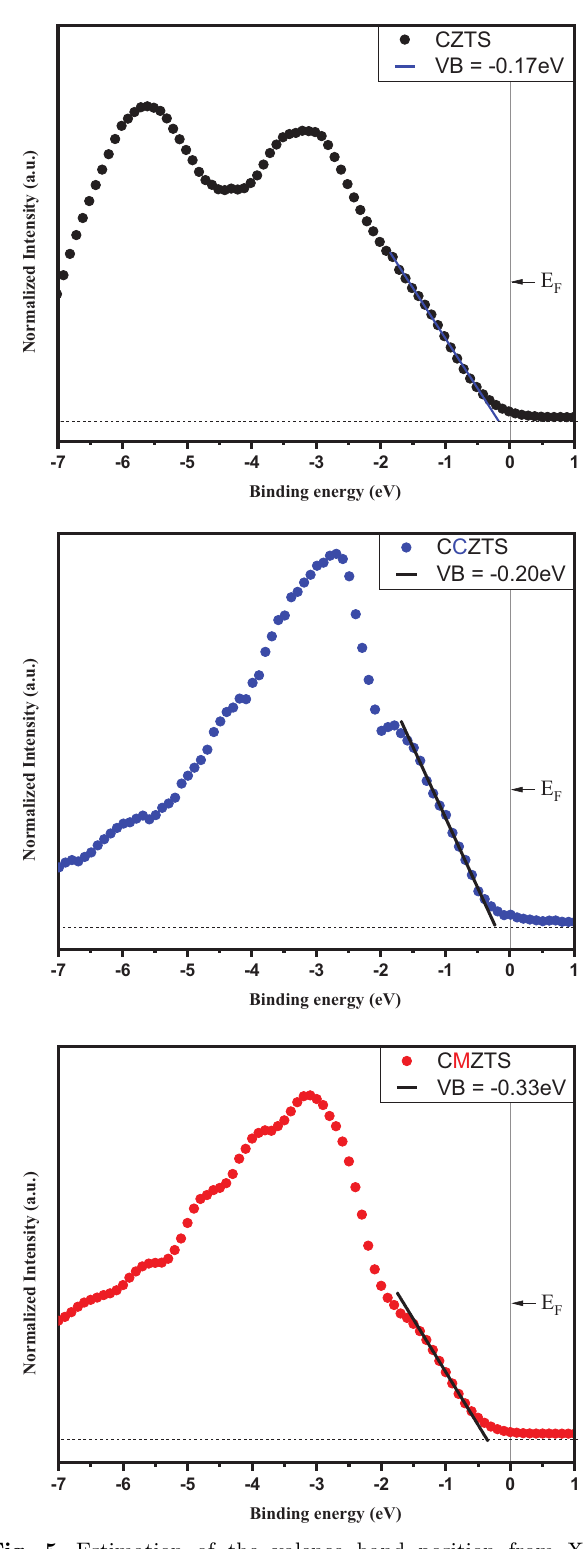
Fig. 5. Estimation of the valence band position from XPS measurement. (a) CZTS, (b) CCZTS, (c)